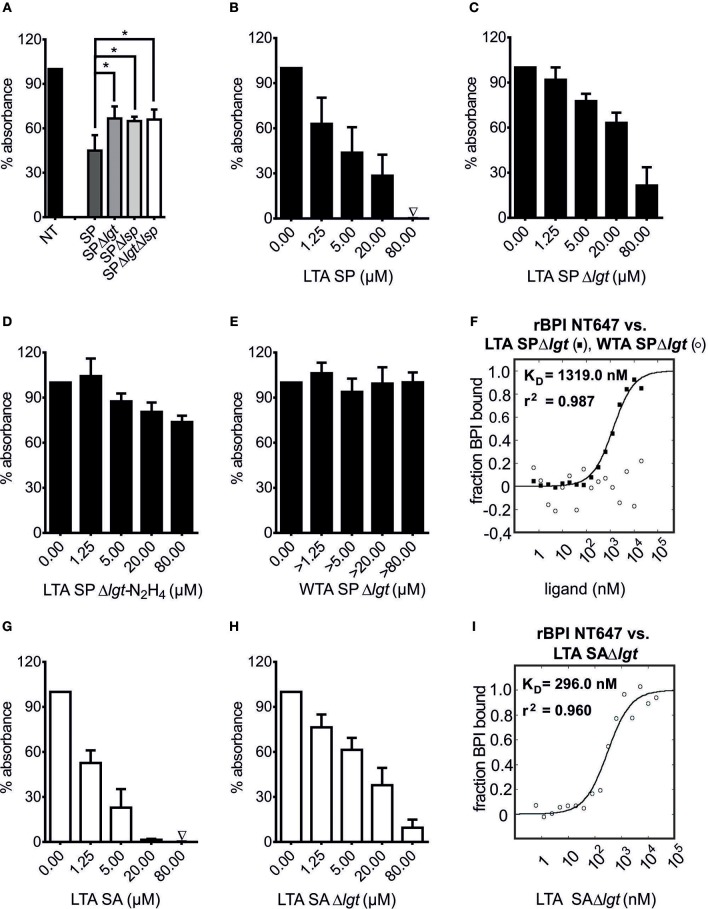
LTA is an additional ligand of BPI in Gram-positive bacteria. BPI binding assay (A–E, G,H). MST binding assay (F,I). Lysates of S. pneumoniae D39Δcps, D39ΔcpsΔlgt (SPΔlgt), D39ΔcpsΔlsp (SPΔlsp) and D39ΔcpsΔlgtΔlsp (SPΔlgtΔlsp; 50 μg/ml) were incubated with rBPI to evaluate their potential to inhibit the binding to LPS biotin-coated wells (A, NT: not treated). Statistics for comparison were performed with the unpaired Student's t-test (p-value *p = 0.004). LTA SP and LTA SA were tested for their potential to inhibit the binding of rBPI to LPS biotin-coated wells (B,G). To correct for the effects of contaminating bLPs, LTAs of the corresponding Δlgt strains were tested (C,H). Data for LTA SPΔlgt-N2H4 as well as WTA SPΔlgt are shown (D,E). Absorbance measured at 450 nm for wells with rBPI alone was set to 100% to ensure comparability between the different ligands. Results are shown as means ± SD of three (B–E, G,H) or four (A) biological replicates. rBPI NT647 was monitored in MST when incubated with increasing concentrations of LTA SPΔlgt and WTA SPΔlgt
(F) as well as increasing concentrations of LTA SAΔlgt
(I). KD and r2 values are indicated for LTA SPΔlgt and LTA SAΔlgt
(F,I). Data represent the mean of three technical replicates (F,I).